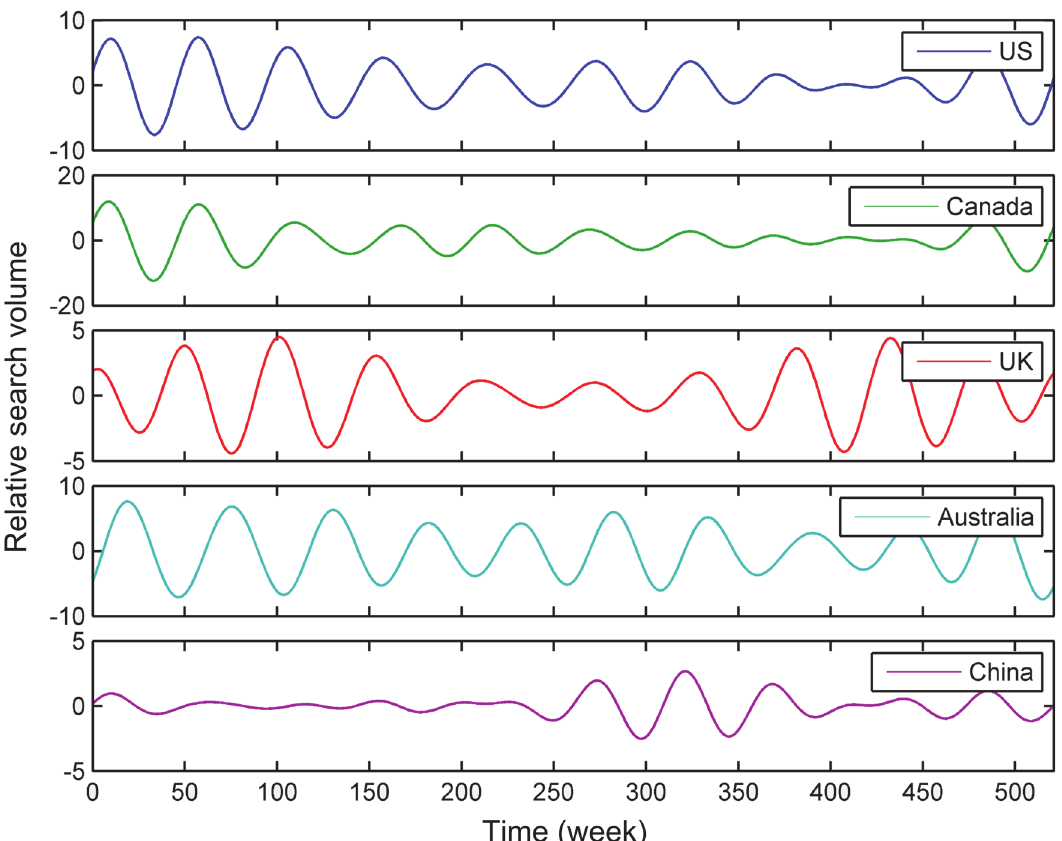
Fig 3. Seasonal components of the tobacco-related search trends of the USA, Canada, the UK, Australia, and China. These seasonal components are extracted by using ideal pass filter on the raw search